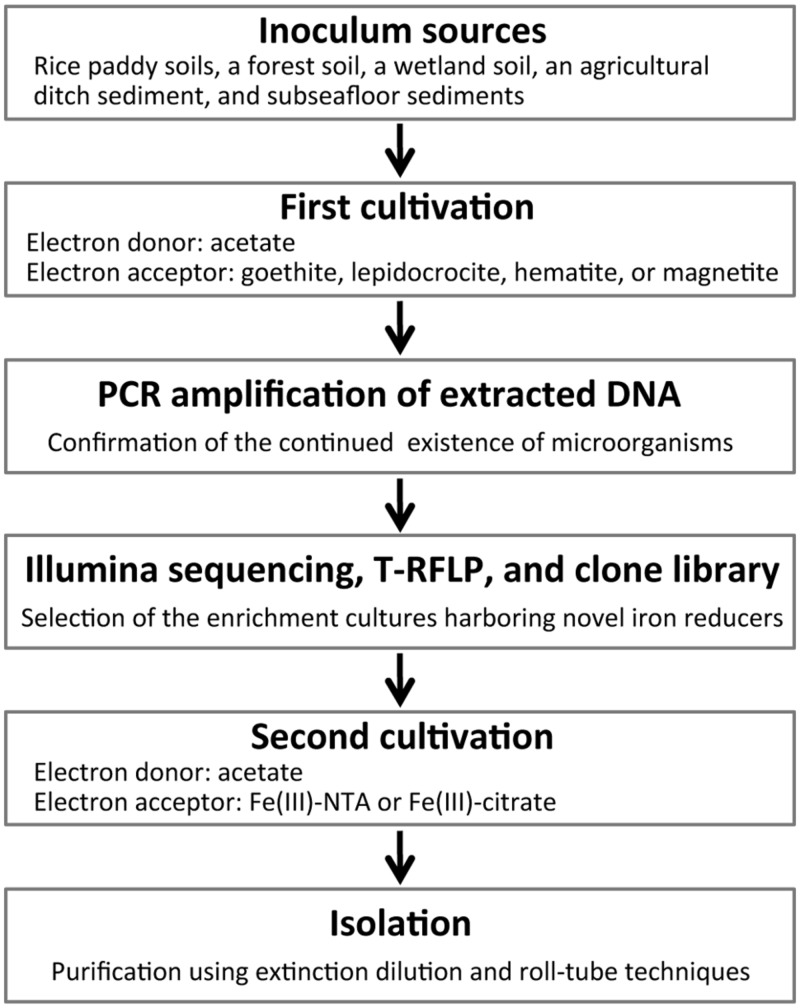
A flow chart of the two-stage cultivation method proposed in this study.